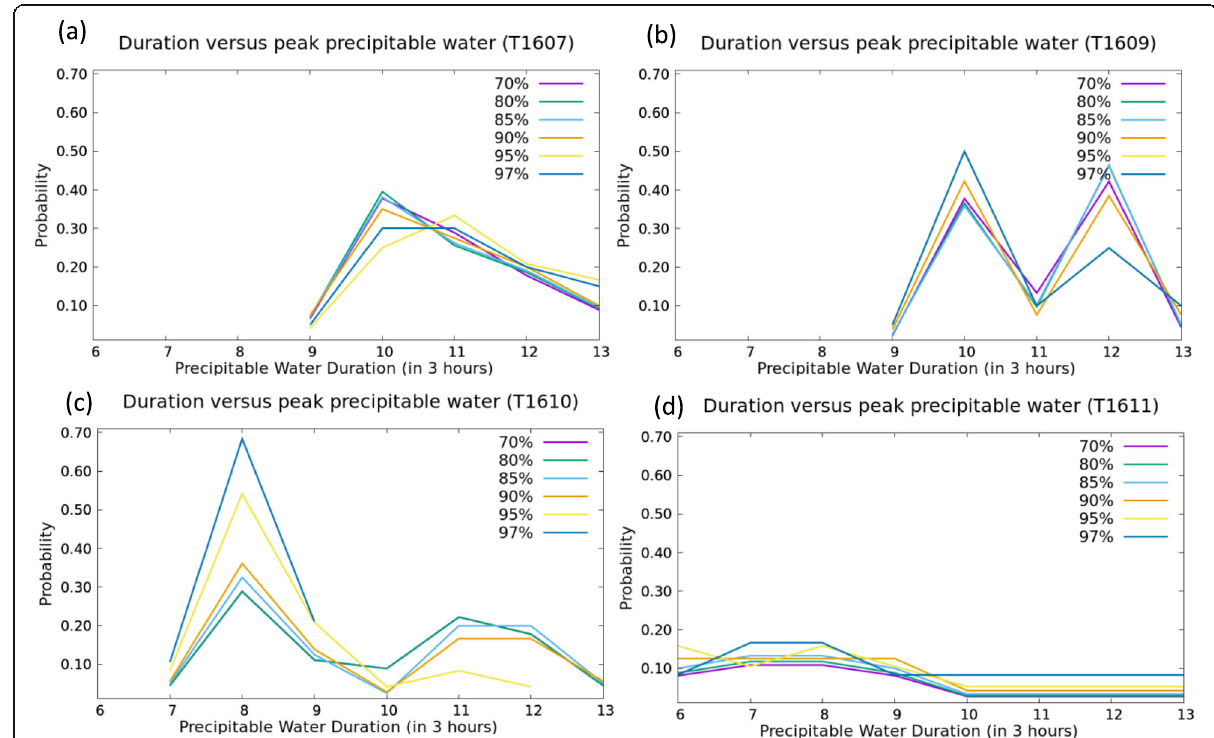
Fig. 10 Atmospheric water vapour from the 3 hourly forecast JRA-55 dataset during the passage of a Typhoon Chanthu, b Typhoon Mindulle, c Typhoon Lionrock, and d Typhoon